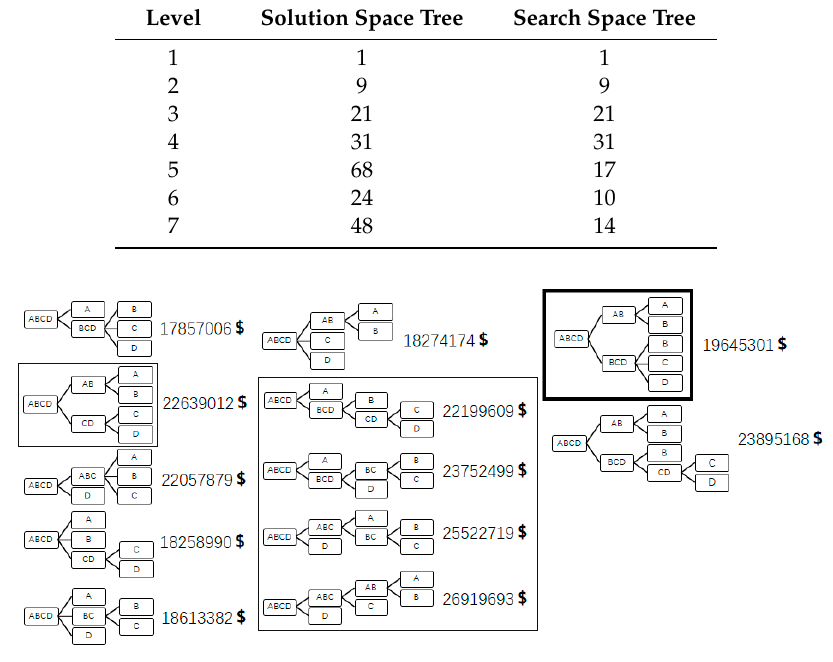
Table 9. Comparison of node numbers between the solution space tree (before pruning) and the search space tree (after pruning) of the four-component alkane case.